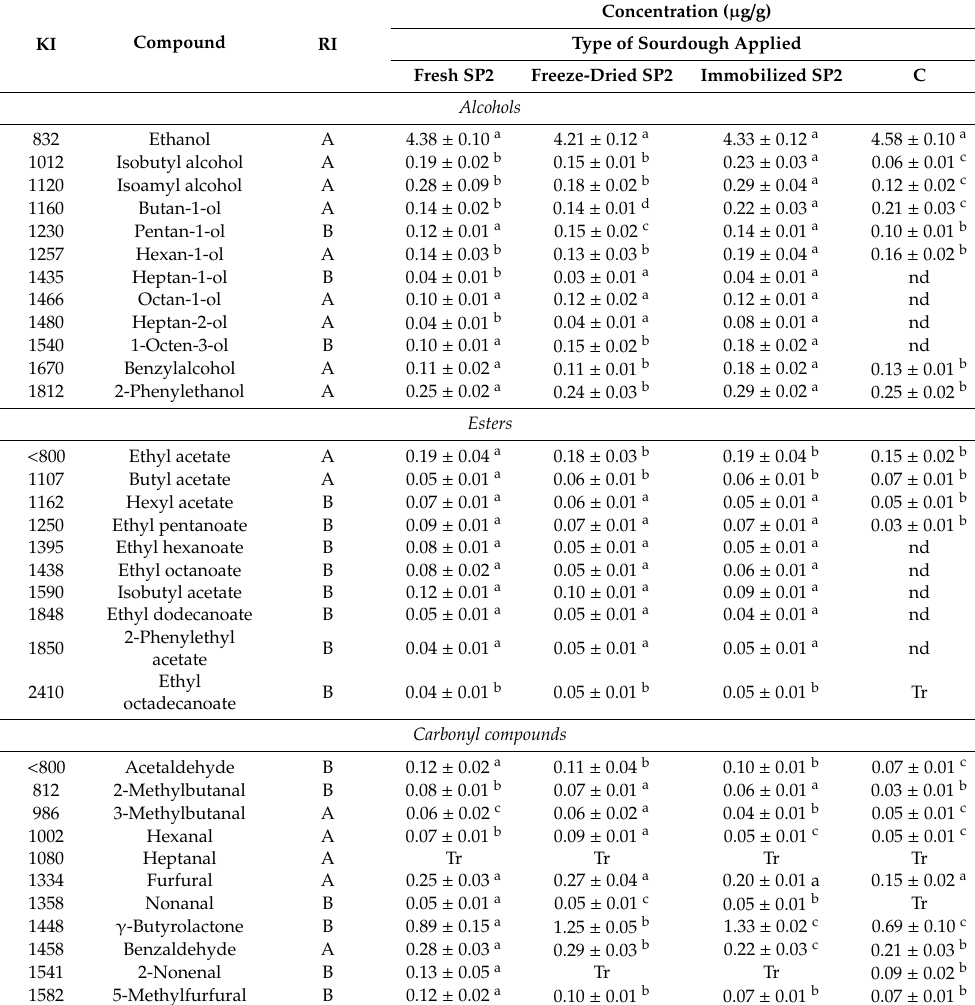
Table 2. SPME GC / MS analysis (semi-quantitative) of flavor-related compounds ( µ g / g) extracted from breads made with sourdoughs containing P. pentosaceus SP2 cells (Fresh SP2), freeze-dried P. pentosaceus SP2 cells (Freeze-dried SP2), immobilized freeze-dried P. pentosaceus SP2 cells (Immobilized SP2), as well as with the commercial sourdough